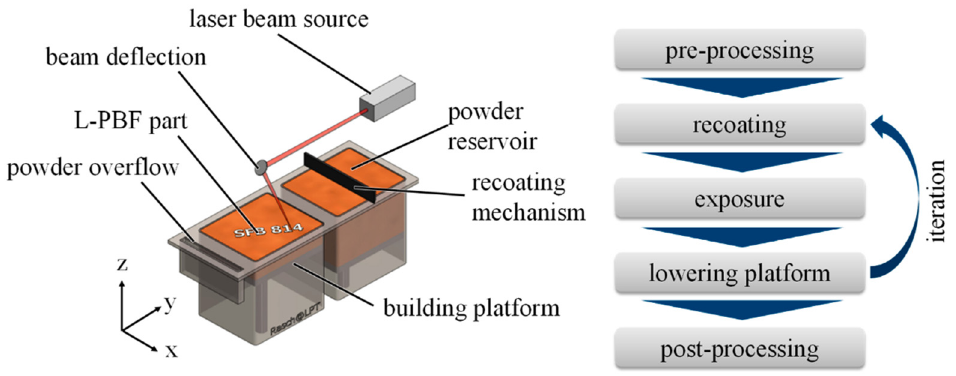
Figure 3. Schematic of Powder Bed Fusion process. Reprinted with permission from ref. [76]. 2018, MDPI 2018,